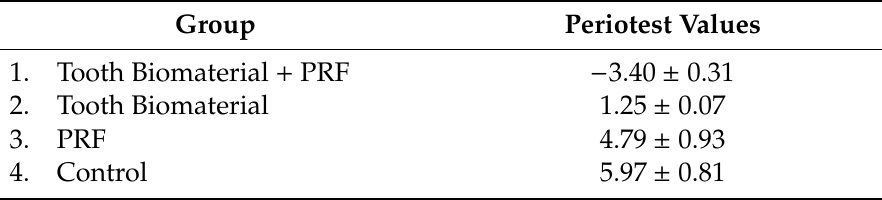
Table 2. Measurement of implant